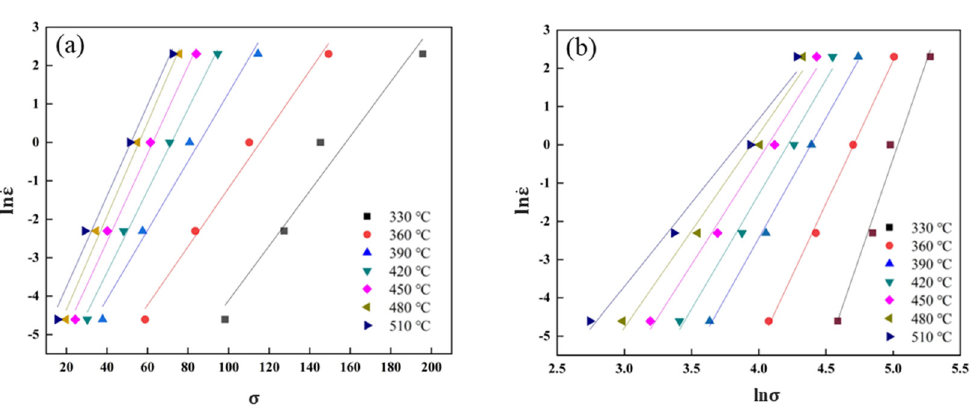
Figure 4. The linear relationships of ln ε versus σ and ln ε versus ln σ . ( a ) ln ε – σ , ( b ) ln ε – ln σ .